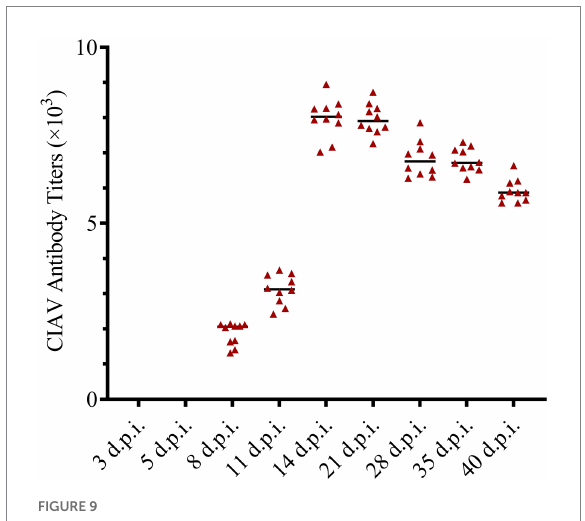
FIGURE 9 Antibody titers against chicken infectious anemia virus (CIAV) in the JS2020-PFV group. Antibody titers against CIAV = log10 titer =(s/N – 2.72) / (–0.64), s is the A650 of tested sample, N is the A650 of negative control provided by the testing